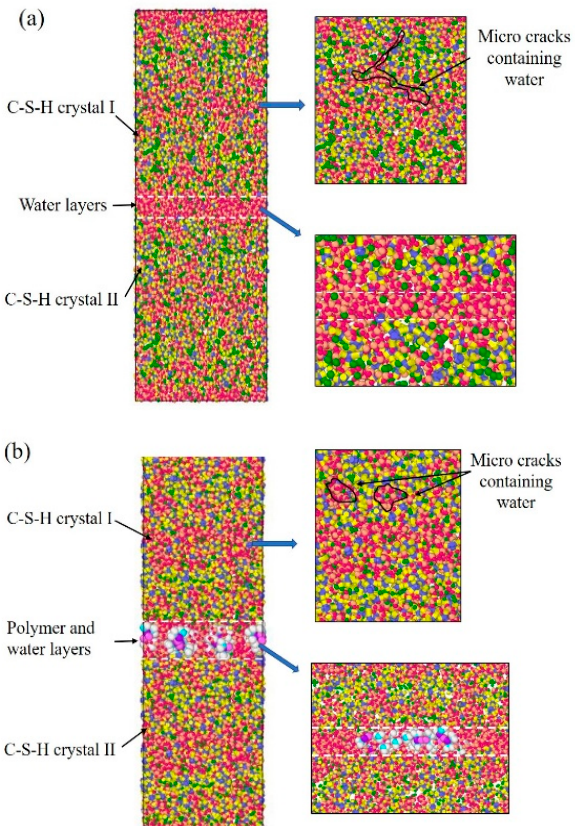
Figure 1. The stacking model of C-S-H: ( a ) pure C-S-H; ( b ) PDMS-modified C-S-H. Uniaxial Stretching Test The optimal energy calculation (300 K) of the proposed model was performed using NPT synthesis to release the excess stresses, ensuring there was no external pressure in the x , y , and z directions. The PDMS-modified C-S-H model was stretched along the x , y , and z axes at a rate of 0.08 ps − 1 . When the model is stretched along a certain axis, the forces in the other two directions, which are orthogonal to the principal stress, are zero. The value of the pressure in the tensile direction is equal to the internal pressure.